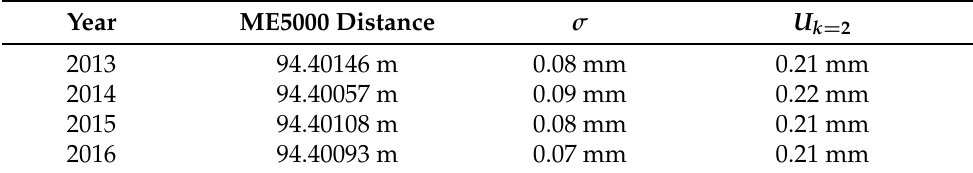
Table 4. Electronic Distance Meter (EDM) distances obtained in years 2013–2016 and their corre- sponding standard deviation and expanded uncertainty U ( k = 2).